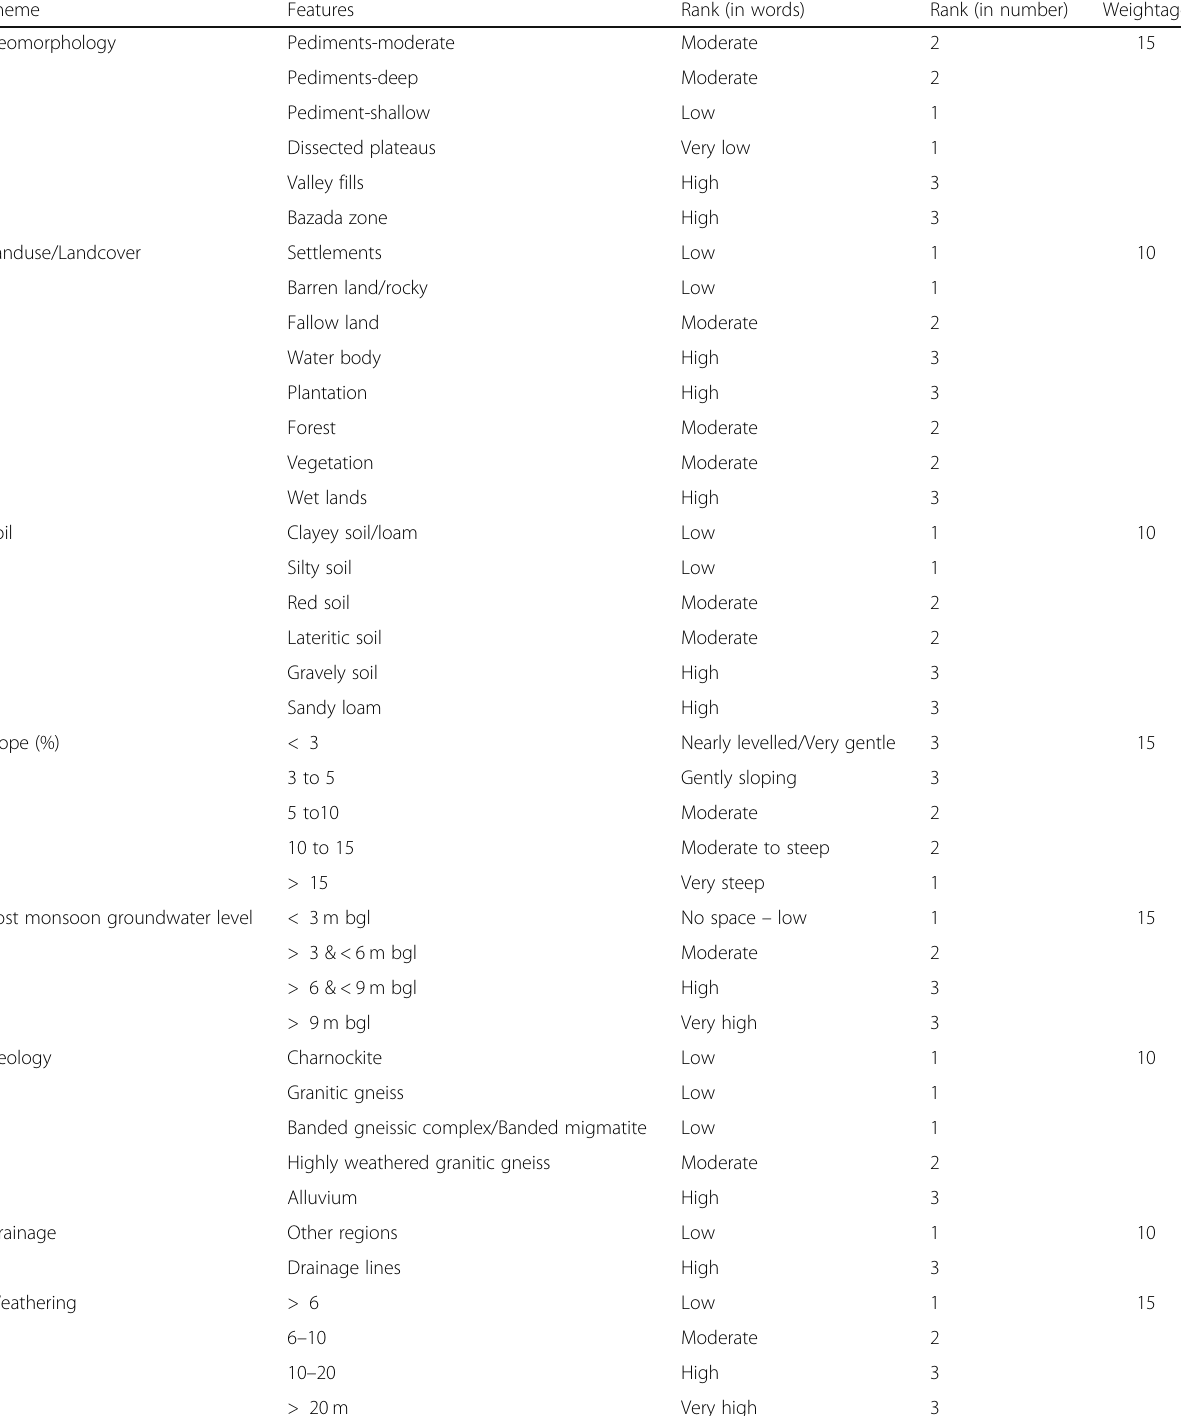
Table 1 Theme wise features, ranking & weightage